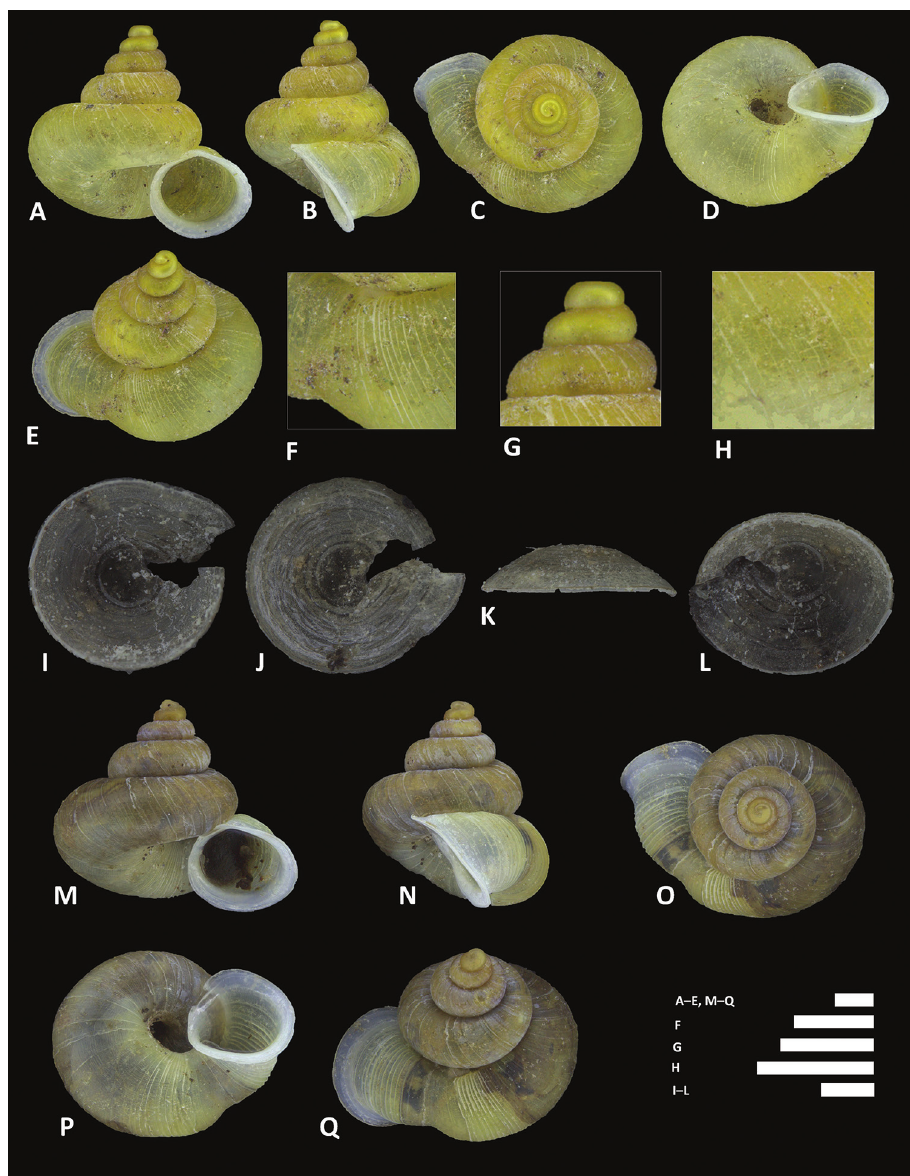
Figure 12. Alycaeus charasensis sp. n. A–E Shell of holotype, BOR/MOL 8400 F–H Close up of shell of holotype, BOR/MOL 8400 I–L Operculum of paratype, BOR/MOL 6891 M–Q Shell of paratype, BOR/MOL 267. Scale bars: A–G, M–Q, H 1 mm; I–L 0.5 mm. All photographs by Junn Kitt